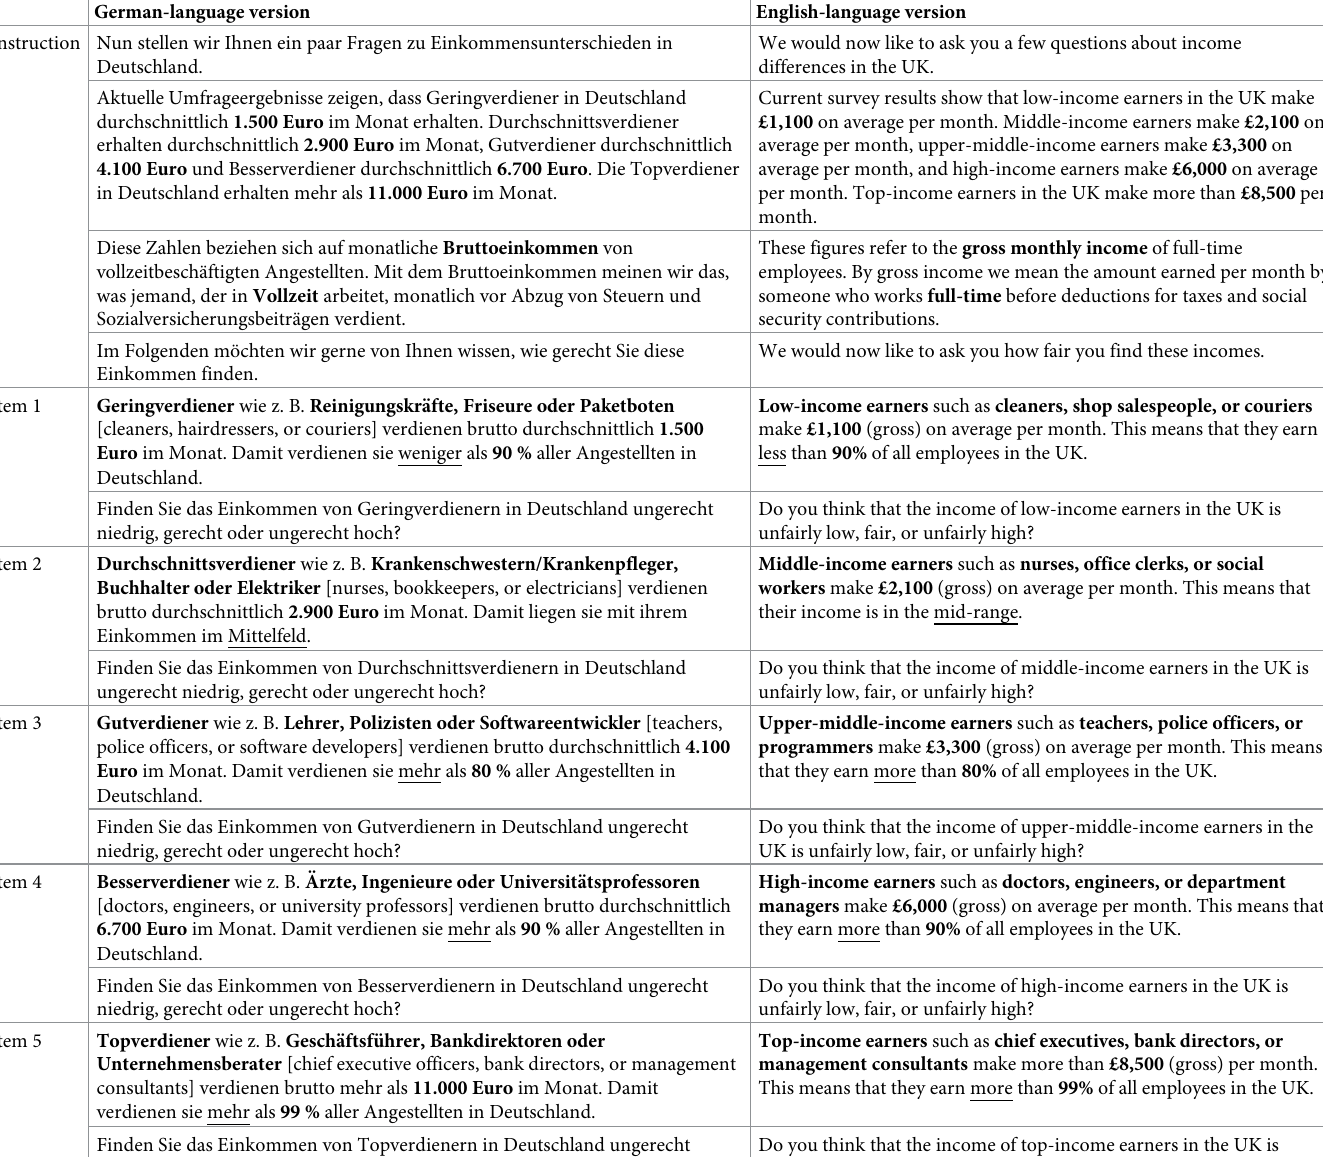
Table 2. Wording of the JEID items by language version. German-language version English-language